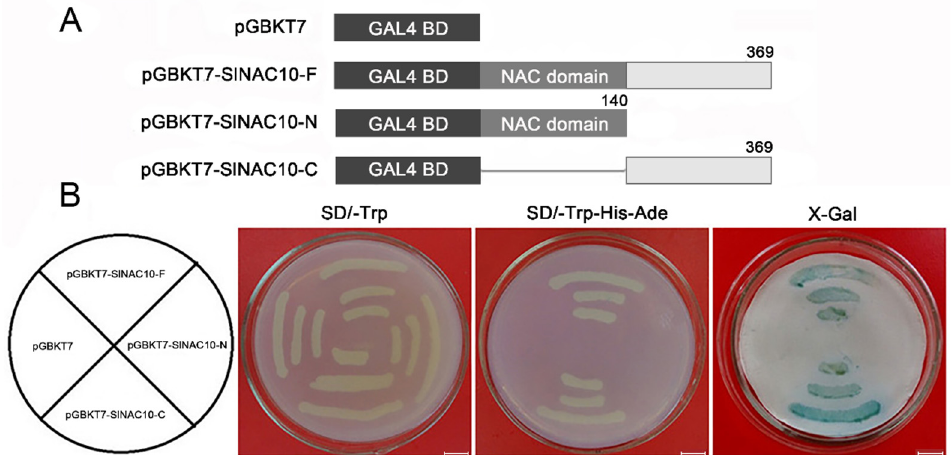
Figure 4. Trans-activational analysis of Sl NAC10 in yeast. ( A ) Schematic diagrams of the pGBKT7 vector, full-length (pGBKT7- SlNAC10 -F), N-terminal region (pGBKT7- SlNAC10 -N), and C-terminal region (pGBKT7- SlNAC10 -C) of the Sl NAC10 protein, which were fused to the GAL4 DNA-binding domain. The numbers indicate the positions of the amino acids. ( B ) Growth on the selective medium of yeast cells transformed with different constructs using pGBKT7 as a control. The β -galactosidase activity was determined using X-Gal as a substrate. The scale bar corresponds to 1 cm.